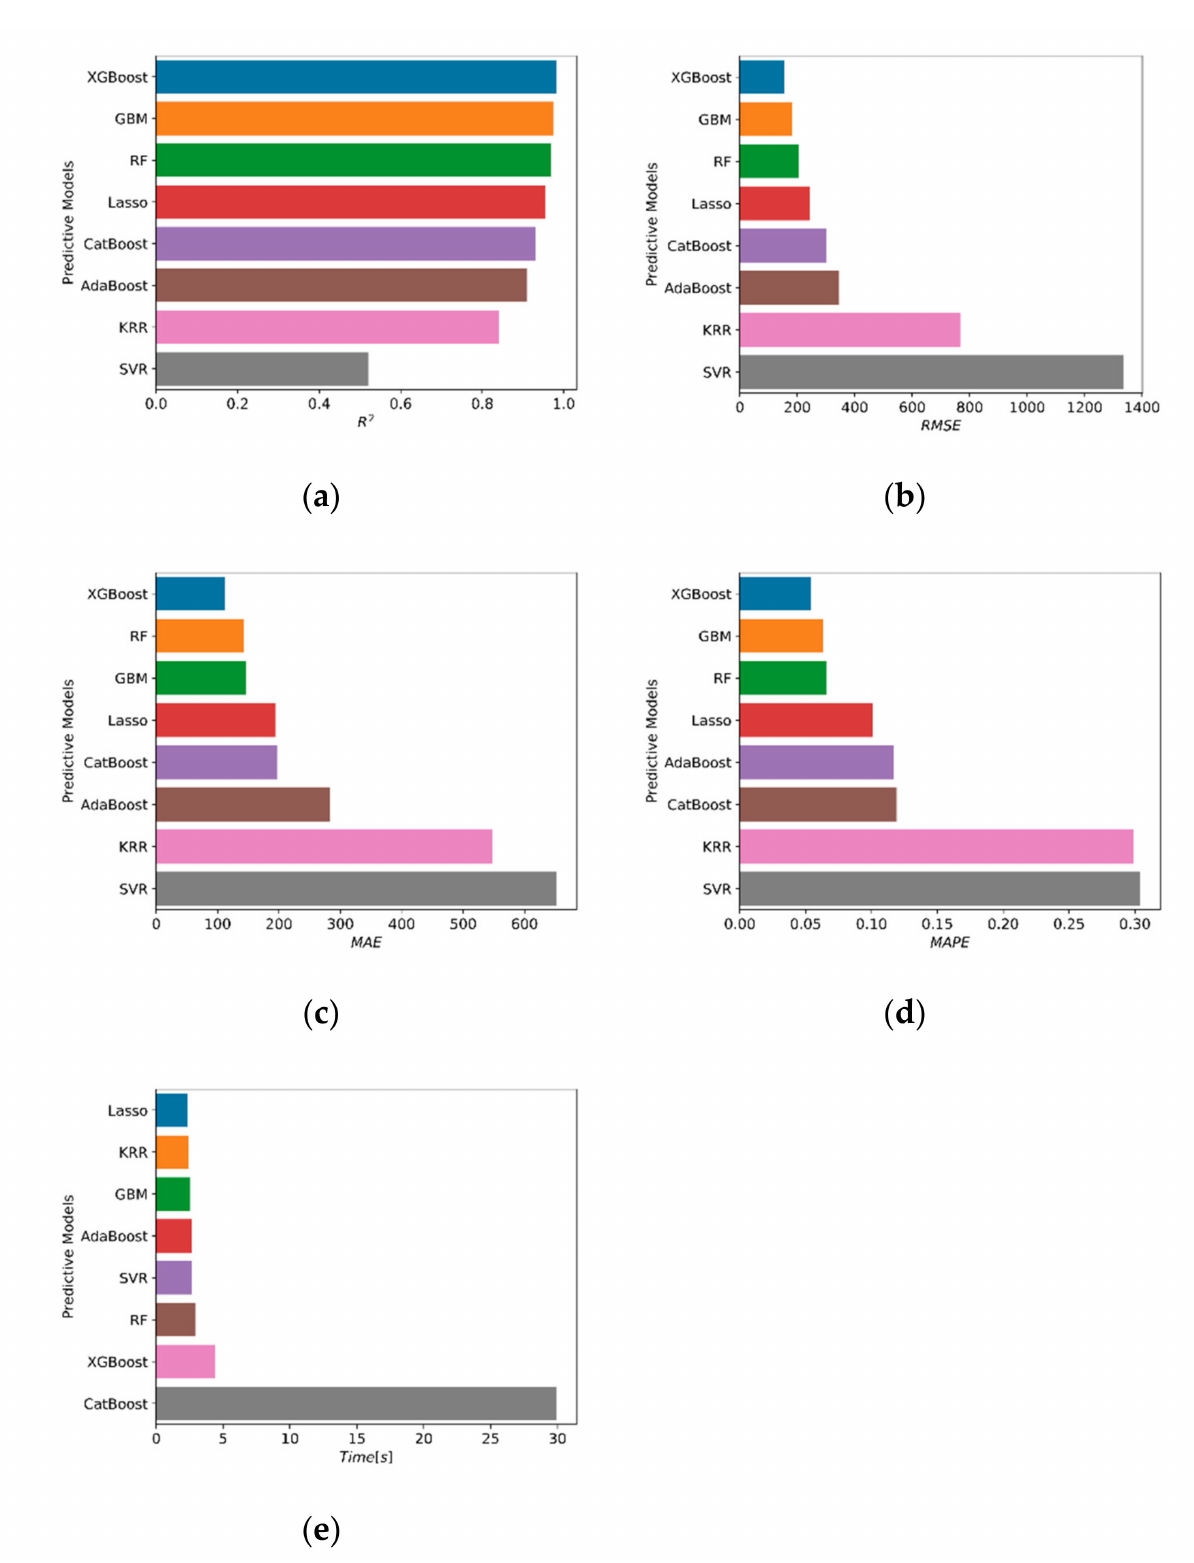
Figure 2. Comparison of predictive models with respect to accuracy and speed; ( a ) R 2 ; ( b ) RMSE; ( c ) MAE; ( d ) MAPE; ( e ) Time